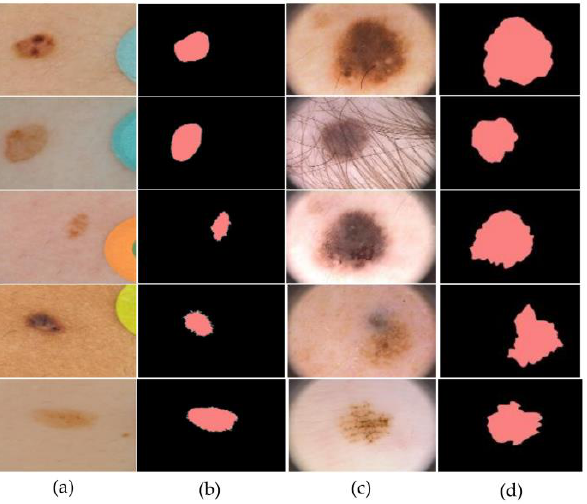
Figure 7. Visualisation results ( a ) input image of ISIC 2018 ( b ) segmented output of ISIC 2018 ( c ) input image of PH2 ( d ) segmented output of PH2.